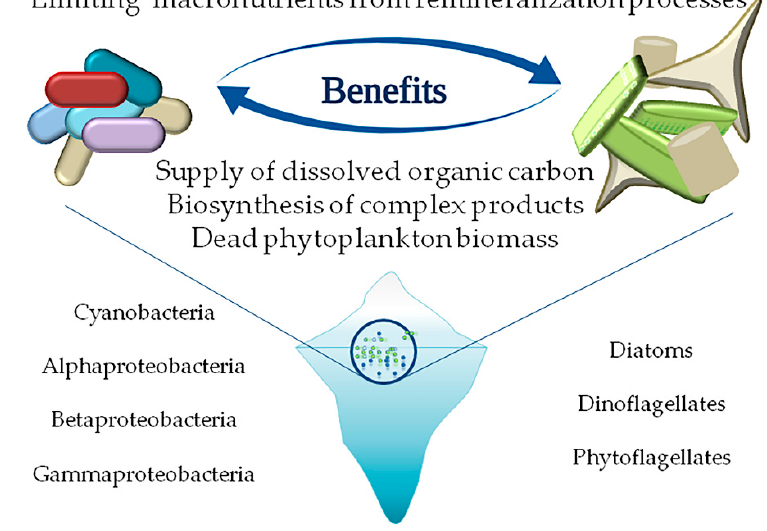
Figure 1. Schematic view of the ecological coupling between phytoplankton-bacteria with benefits deriving from reciprocal exploitation of resources.